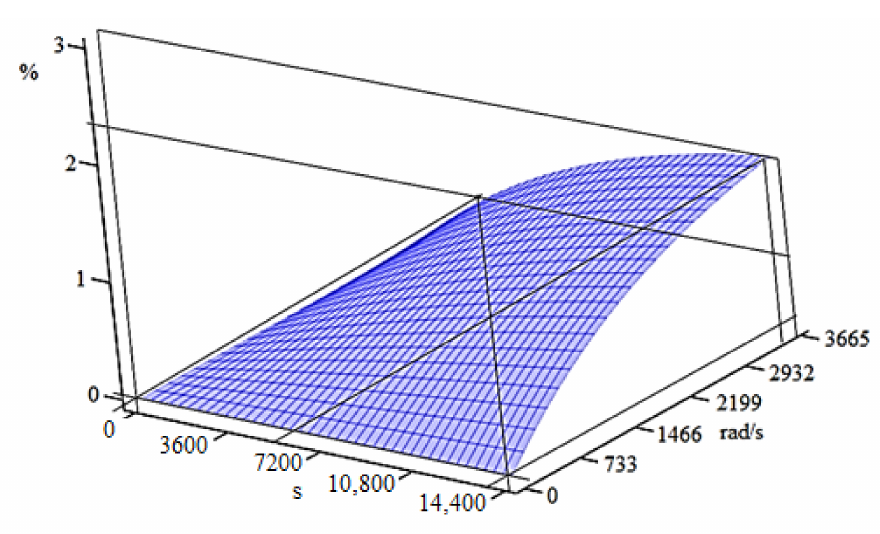
Figure 9. Graphical representation of the interpolation function (9) depending on ( t , ω ), i.e., re- moved/lost material mass, in percentage, due to wear of dental milling